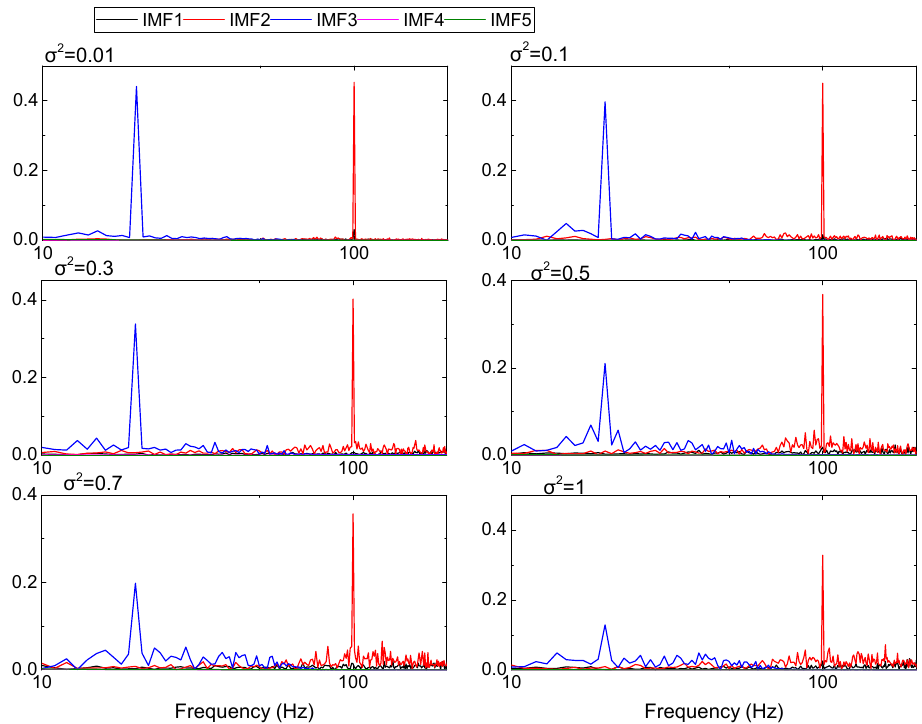
Figure 7. Signal decomposition result by EMD based on the C 2 Hermite interpolation algorithm under different noise variances.